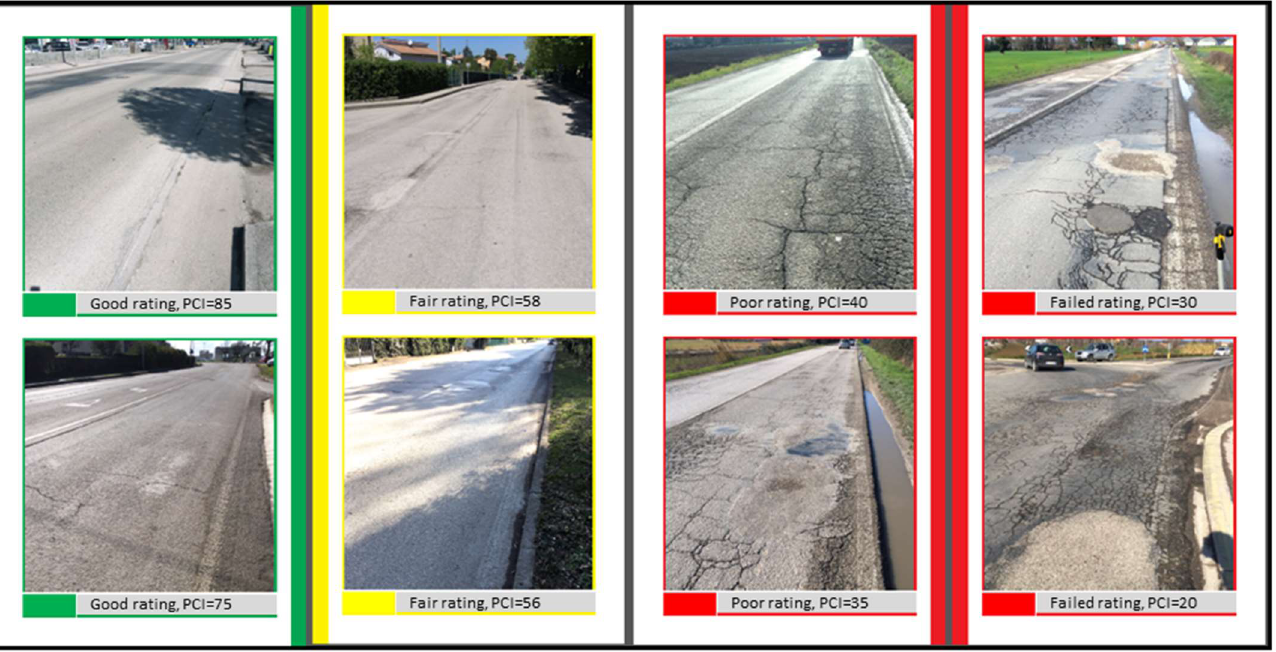
Figure 3. Example of a rating system by visual inspection and comparison.